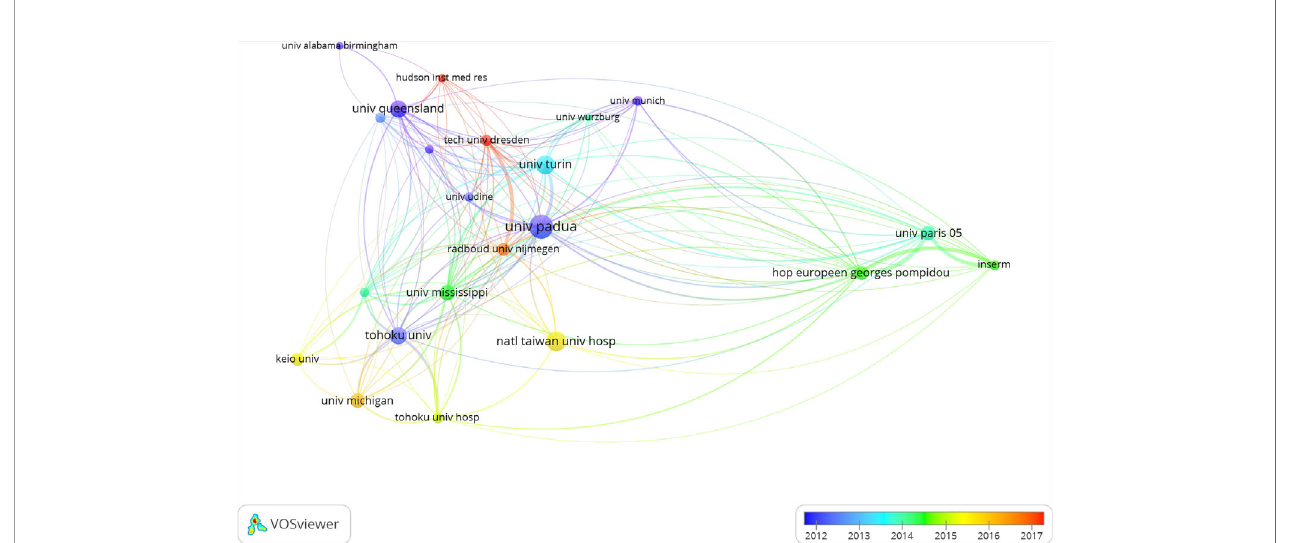
FIGURE 4 | Co-authorship overlay visualization map of institutions. The color of each circle corresponds to the average publication year, the size of a circle is proportional to the number of literatures, and the thickness of the connecting line indicates the cooperation frequency.